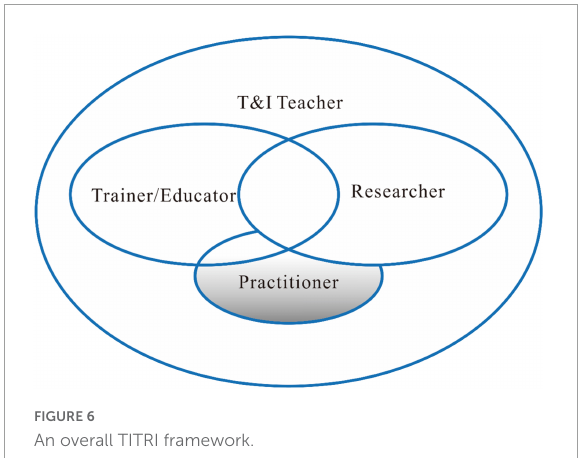
FIGURE6 An overall TITRI